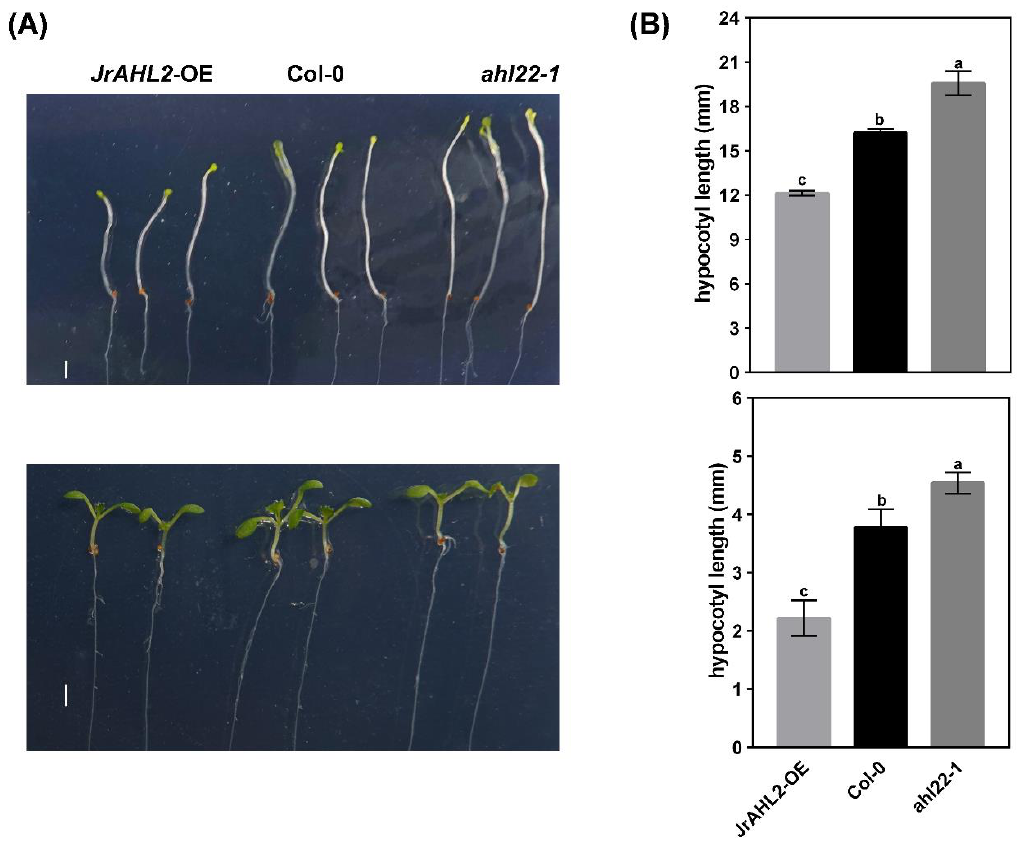
Figure 12. JrAHL2 affects hypocotyl elongation. Samples were photographed ( A ), ( upper panel ) for darkness, and ( lower panel ) for normal photoperiod and the length of the hypocotyl was analyzed ( B ). Bar = 2 mm. The columns represent the mean values of three replicates ± standard deviations. Different letters (a, b, c) indicate significant differences, as determined by Student’s t -test at the 0.05 level.